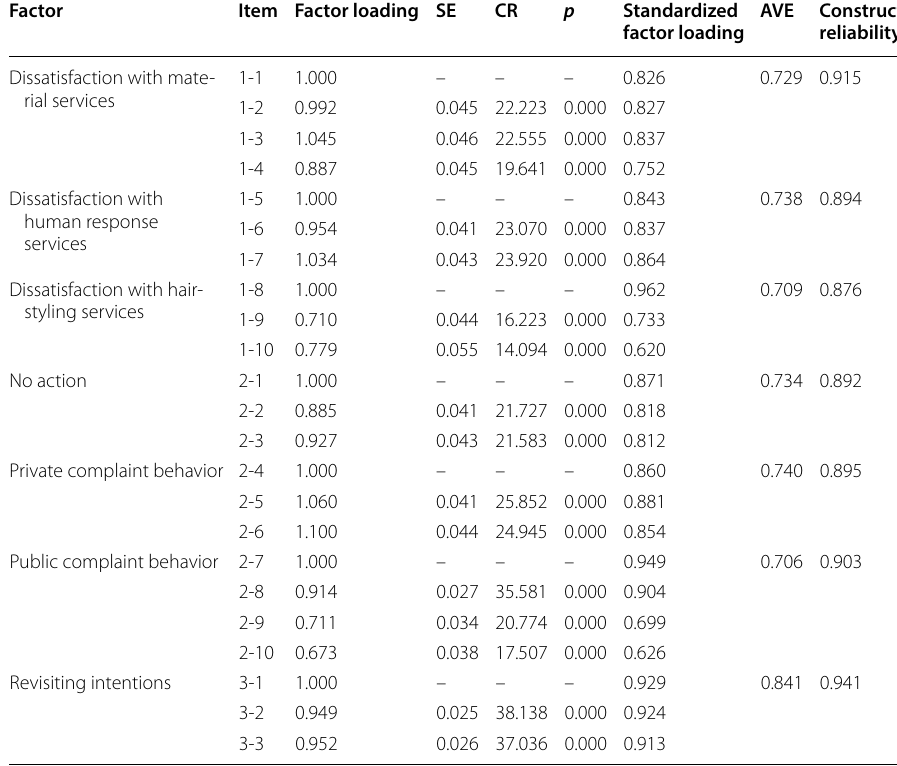
Table 2 Result of confirmatory factor